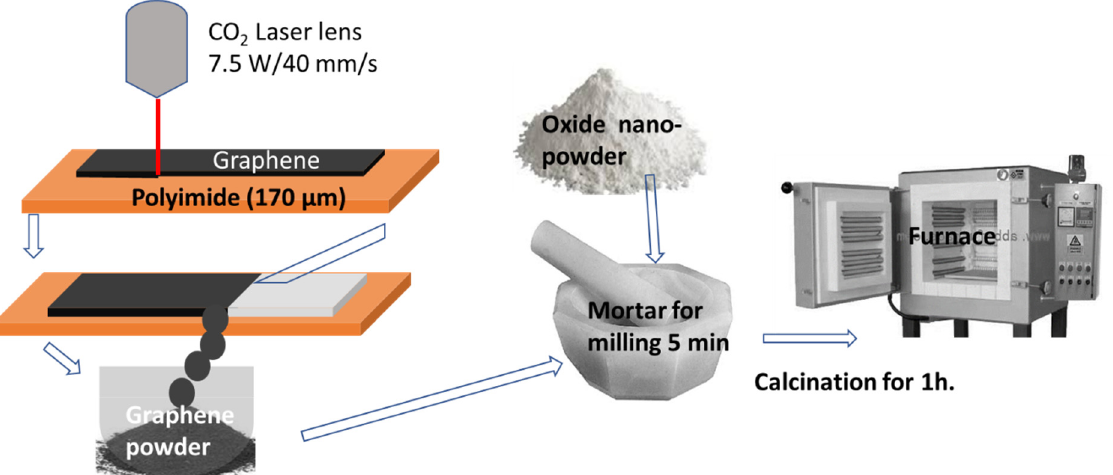
Figure 1. Steps for preparing laser-induced graphene powder by using a CO 2 laser machine and preparing the oxide-graphene nanocomposites.